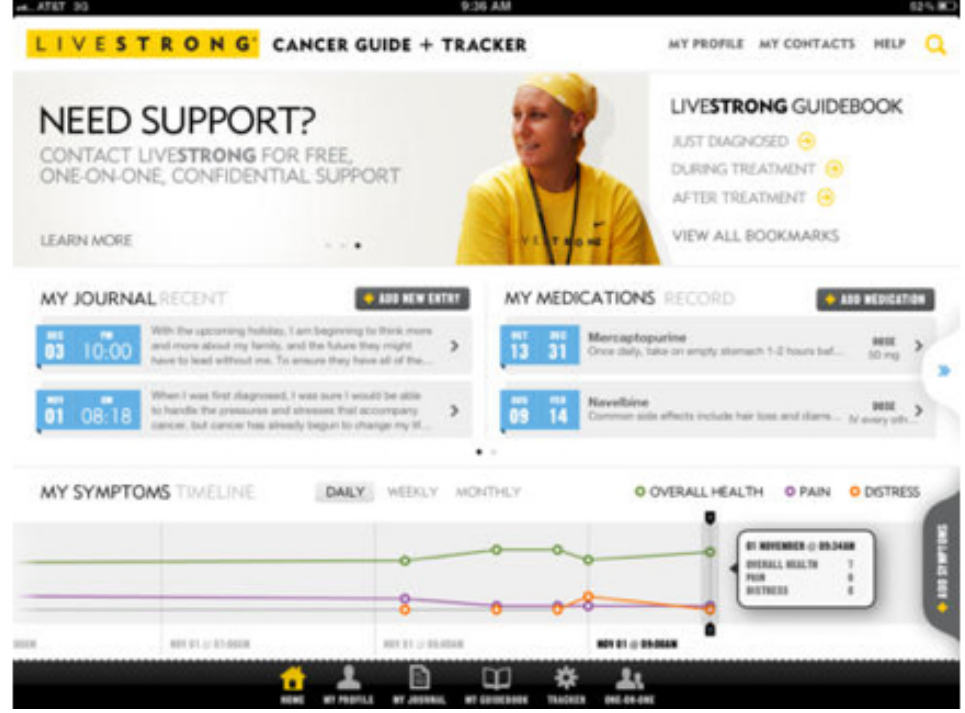
Figure 9. Livestrong Cancer Guide and Tracker